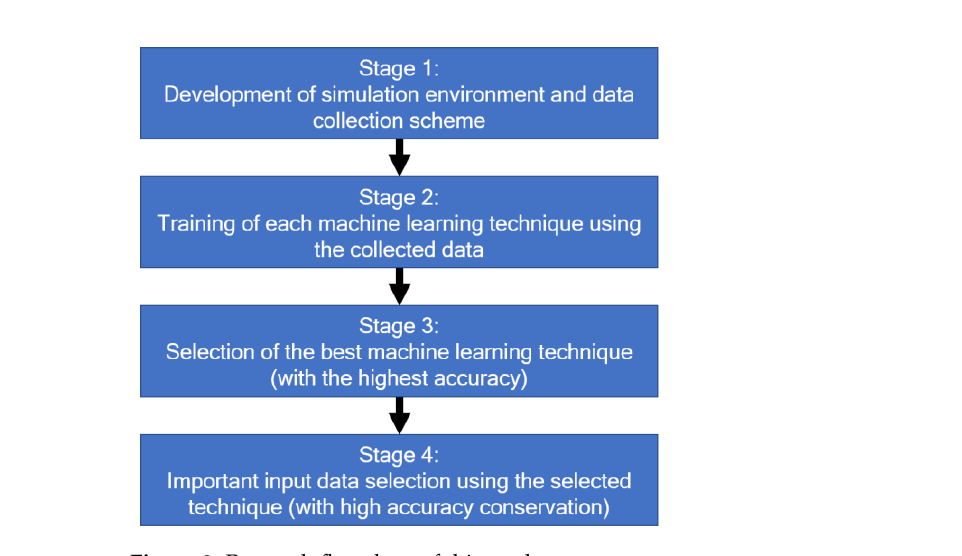
Figure 3. Research flowchart of this study.